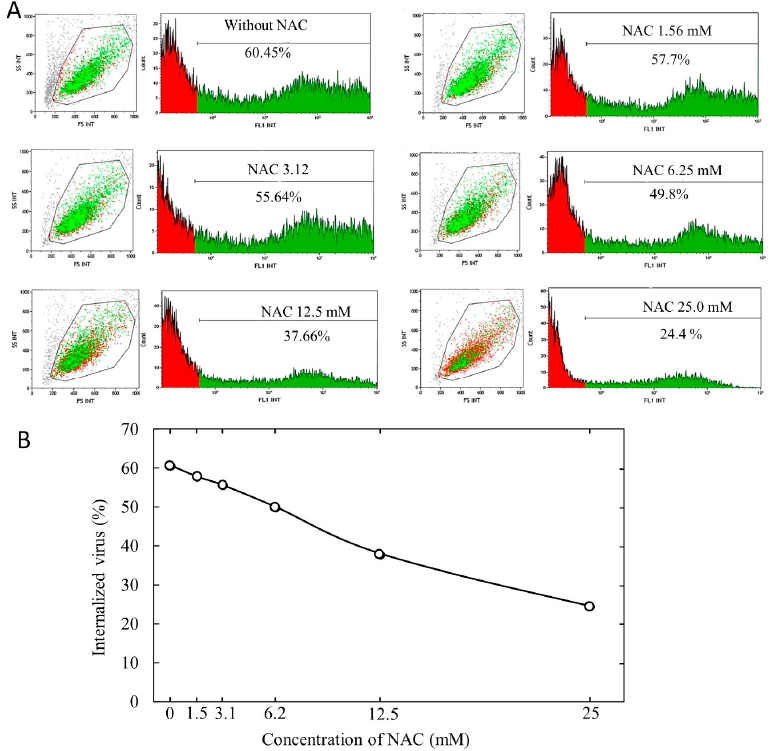
Figure 4. ( A ). Examples of cytofluorimetric analyses of ACE2-HEK293 cells exposed to delta SARS-CoV-2 pseudovirus (10,000 TU/culture), either in the absence or in the presence of varying concentrations of NAC, ranging between 1.56 and 12.5 mM. The green dots and areas in the cytofluorimetric plots reported at each NAC concentration indicate cells in which the pseudovirus was internalized, whereas the red dots and areas indicate pseudovirus-free cells. ( B ). Virus internalization curve as related to NAC concentration.